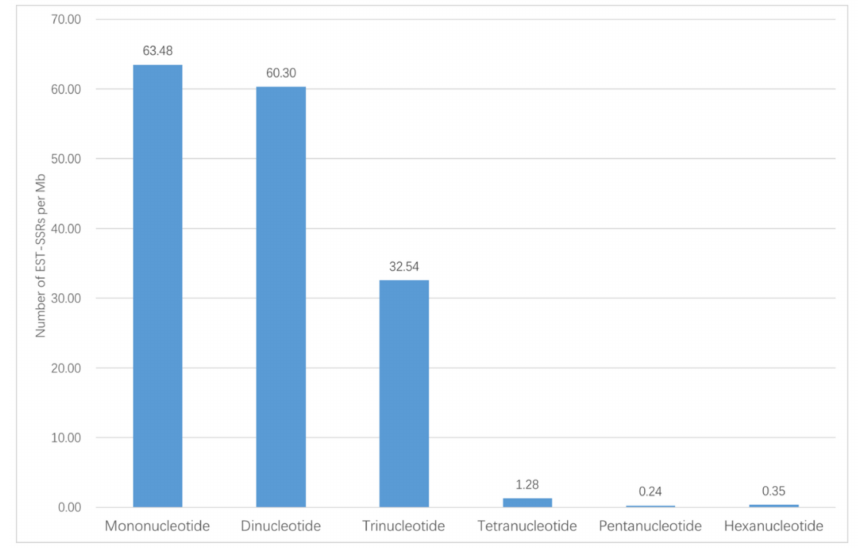
Figure 2. Details of the density of each type of